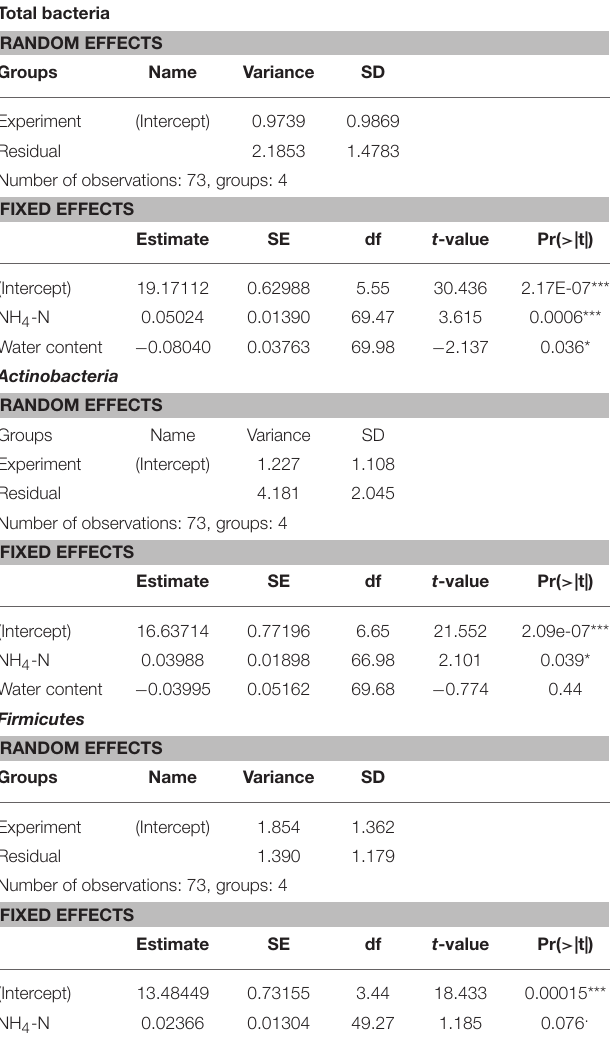
TABLE 3 | Effect of soil water content, ammonium-N concentration and sampling time on the abundance of ribosomes of total bacteria, Actinobacteria and Firmicutes .